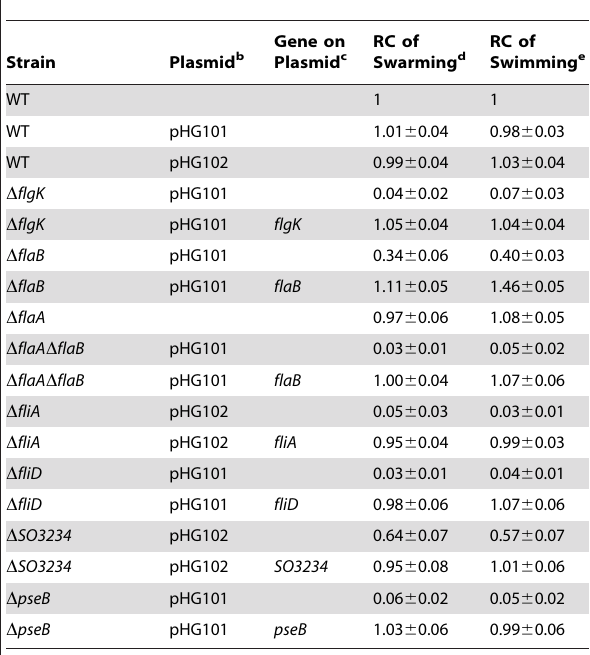
Table 1. Motility of S. oneidensis flagellar mutants a .